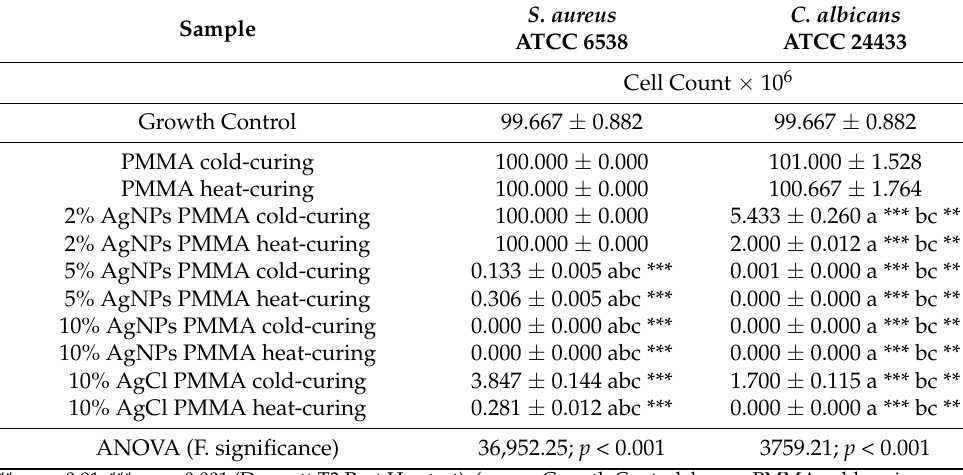
Table 3. Antimicrobial activity of samples against S. aureus and C. albicans strains tested using by a modified microdilution method (a broth disk-diffusion method in broth with viable counting) (log-CFU/mL). The values are averages and SE ( n = 3). Different letters near the means represent significant differences by Dunnett T3 test. S. aureus Sample ATCC